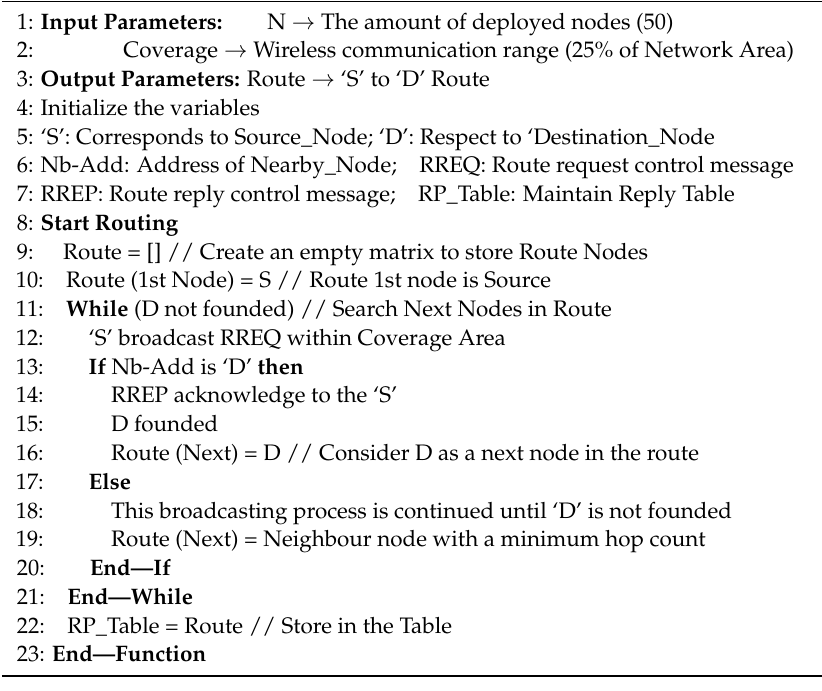
Figure 4. AODV routing Process. Algorithm 1: AODV Routing Protocol